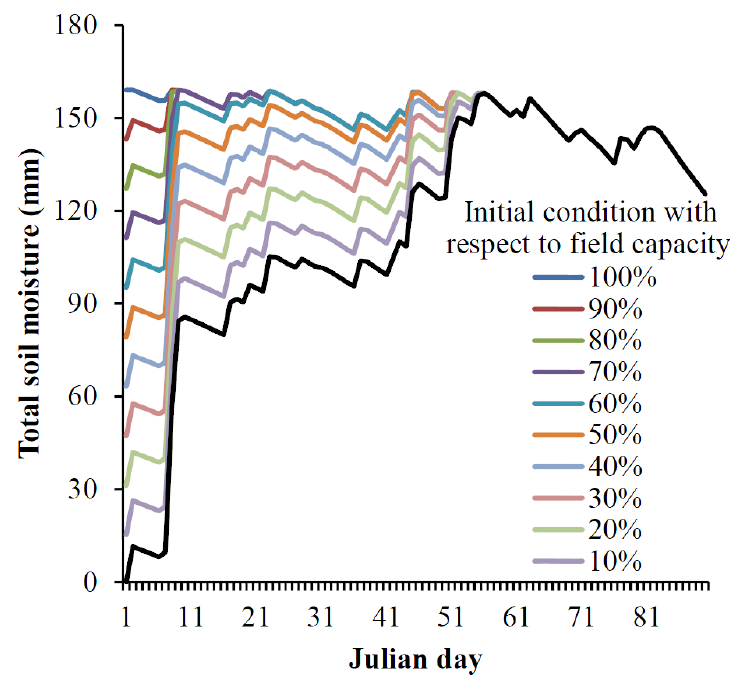
Figure 6. Time series plot of total column soil moisture (mm) over the 11 year simulation for validated river basin at Alabama, USA (the Tallapoosa River basin, MOPEX ID #